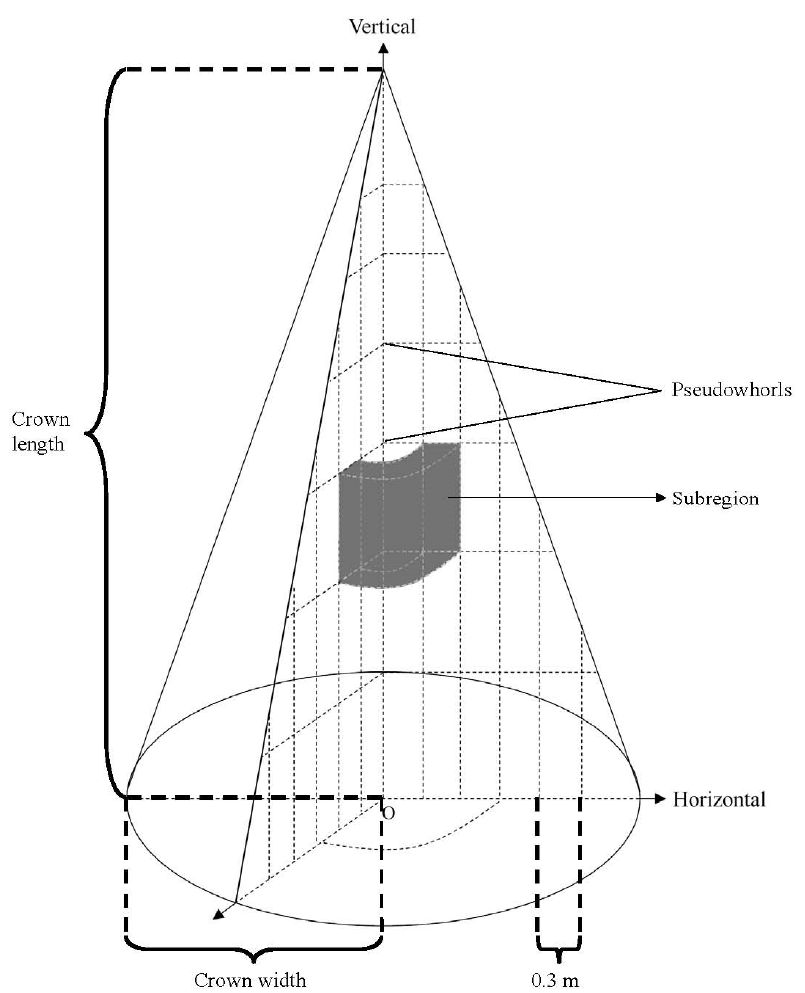
Figure 2. A schematic diagram of the crown attributes of an L. olgensis tree and the principle of sub-region division.